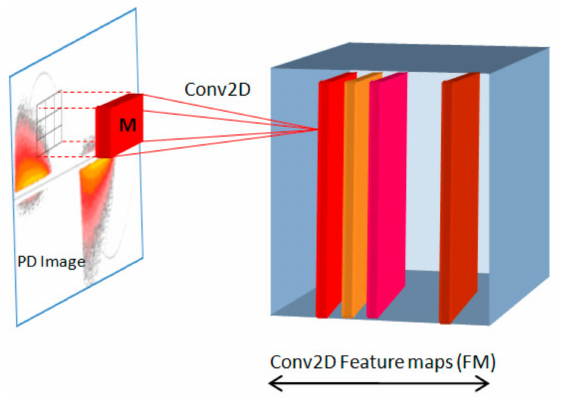
Figure 2. Graphical illustration of feature map layer creation (M—filter). PD—partial discharge.